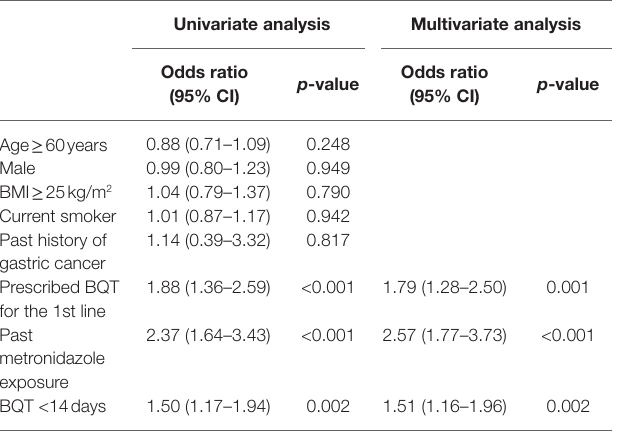
TABLE 4 | Univariate and multivariate analysis of factors related to Helicobacter pylori eradication failure. Univariate analysis Multivariate